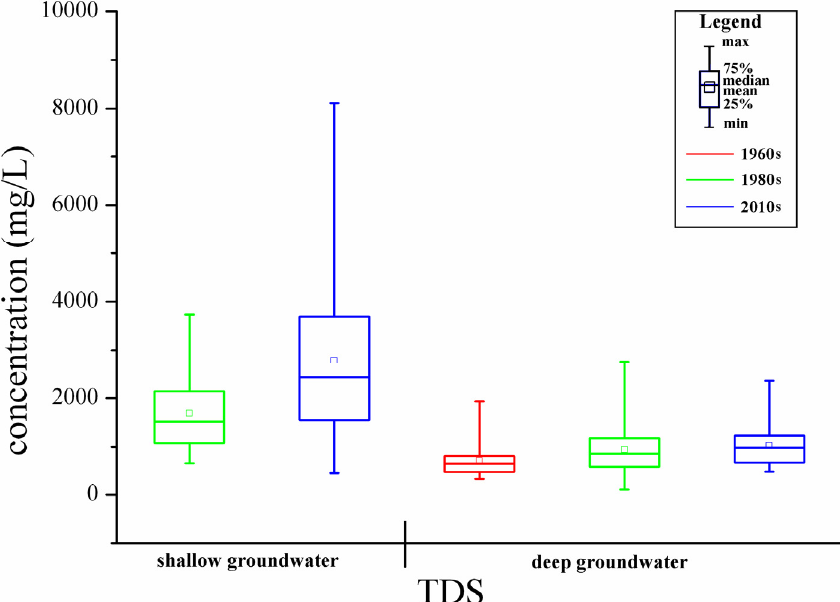
Figure 10. TDS concentration distribution in shallow and deep groundwater among decades.